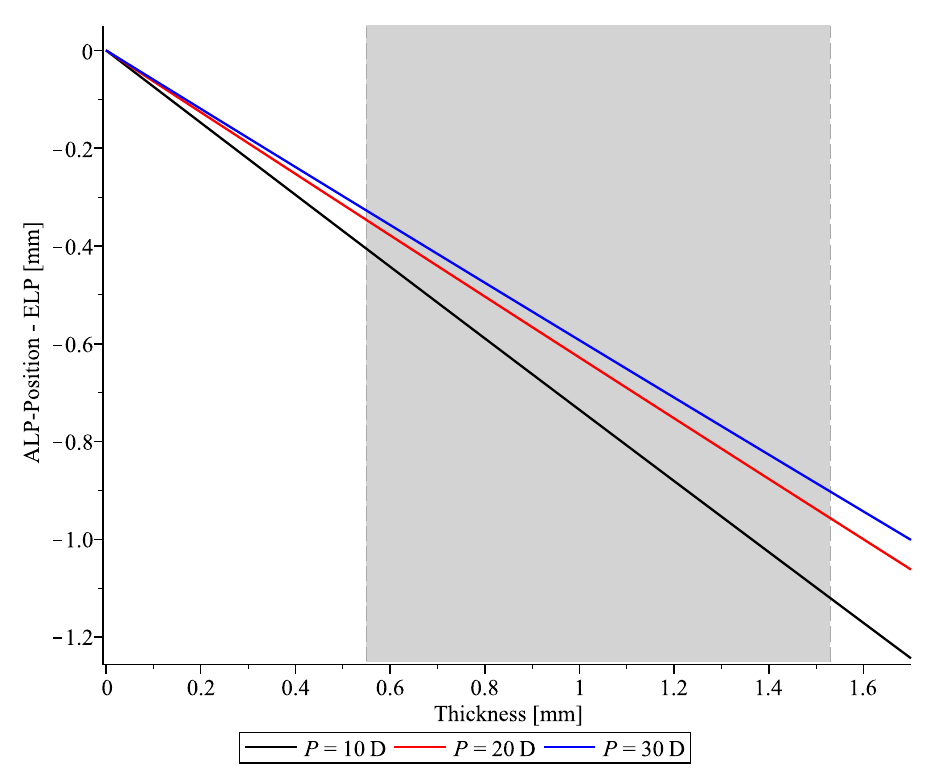
Fig 2. The difference between the anterior intraocular lens (IOL) vertex and the effective lens position of the thin lens equivalent as a function of IOL-thickness for IOLs with optical power P = 10 D, 20 D, 30 D. The clinically relevant range of IOL-thickness is marked in